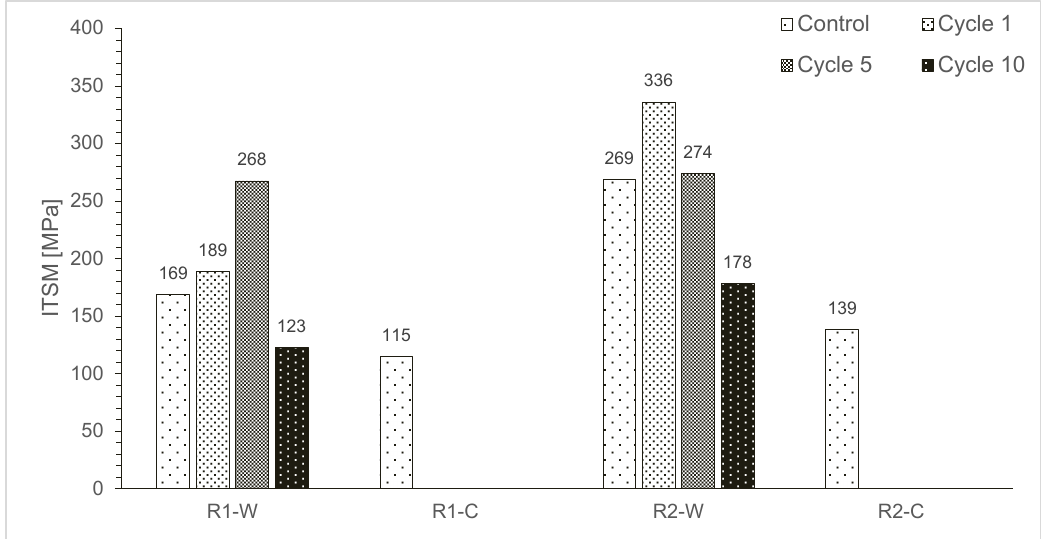
Figure 6. ITSM (@5 °C) values for each mixture vs. cycles. Figure 6. ITSM (@5 ◦ C) values for each mixture vs. cycles. At t = 0, the R1-C mixture exhibits the lowest stiffness values, while the R2-W